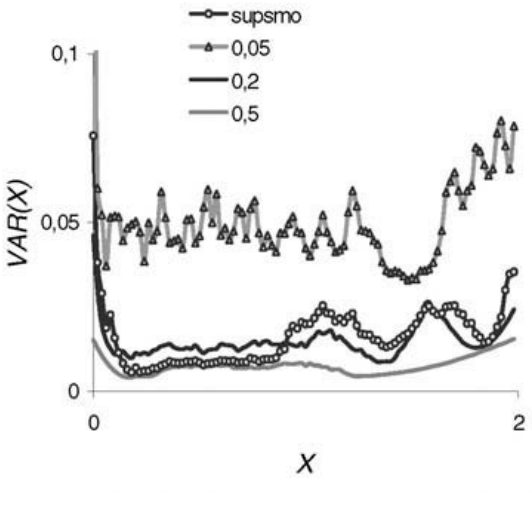
Figura 7 – Modello II: varianza degli stimatori.